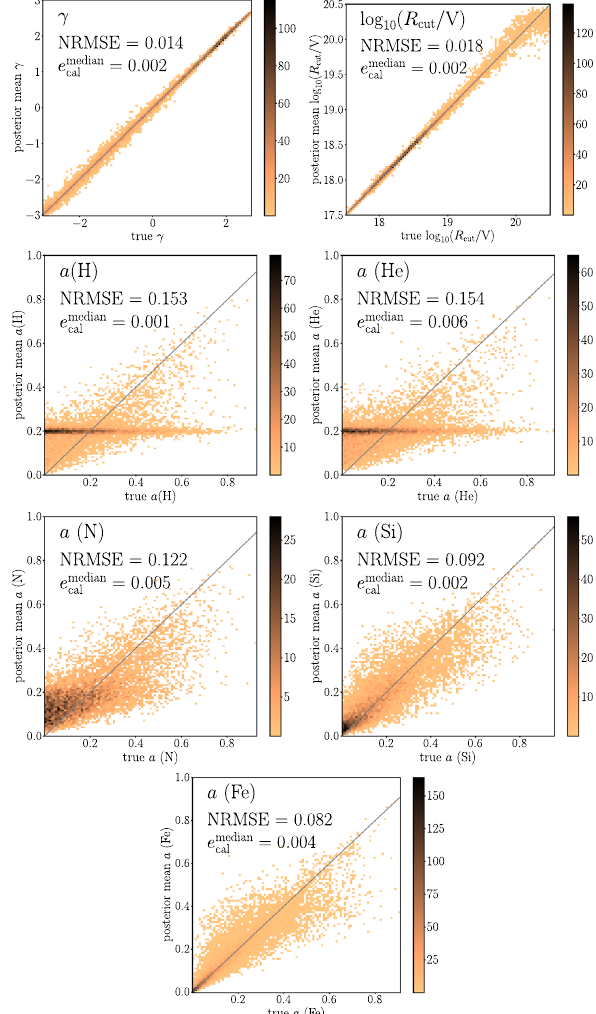
Fig. 8 2 D histograms of the 7 source parameters γ , R cut and a ( H , He , N , Si , Fe ) using 10 4 test datasets. The true value of the simula- tion is shown on the horizontal axis, the mean of the cINN posterior on the vertical axis. The gray straight line represents the position of perfect